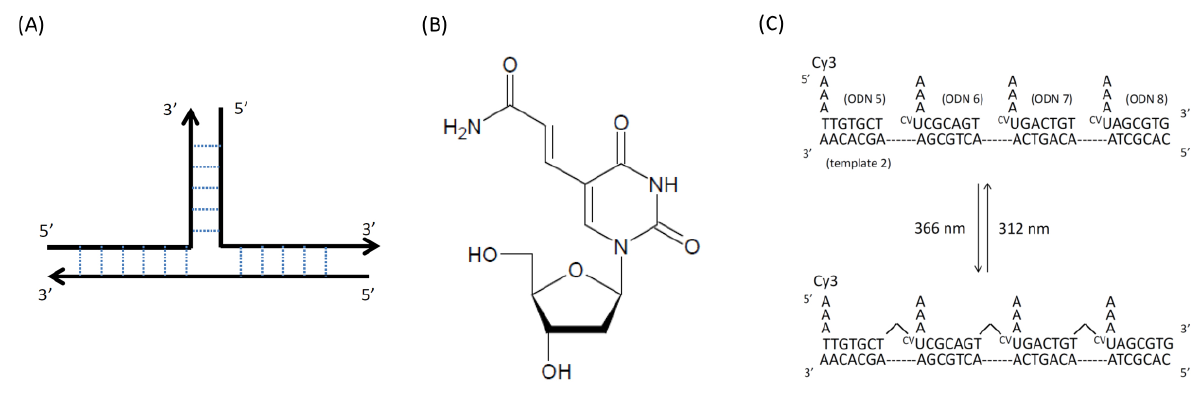
Figure 3. ( A ) Illustrated branched DNA; ( B ) chemical structure of CV U nucleotide; ( C ) schematic illustration for reversible photoligation with CV U and Cy3.